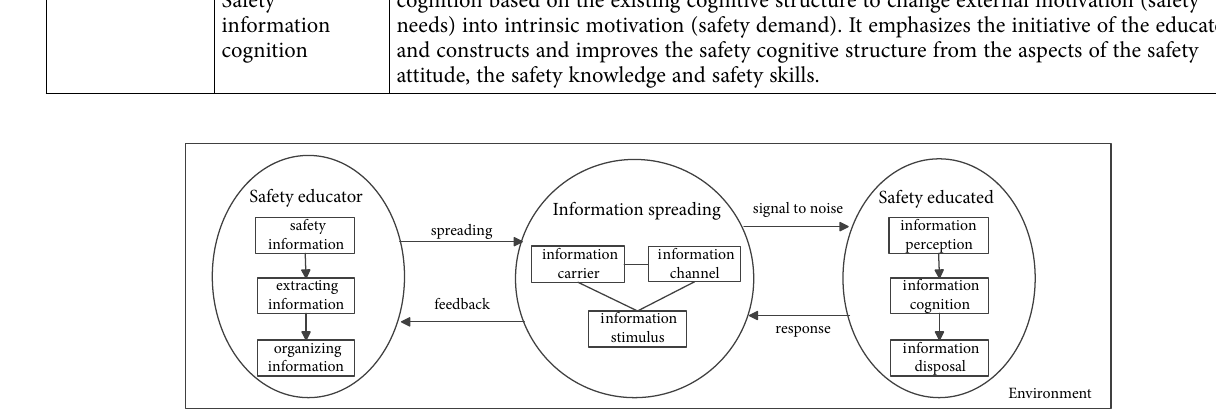
Safety education implementation